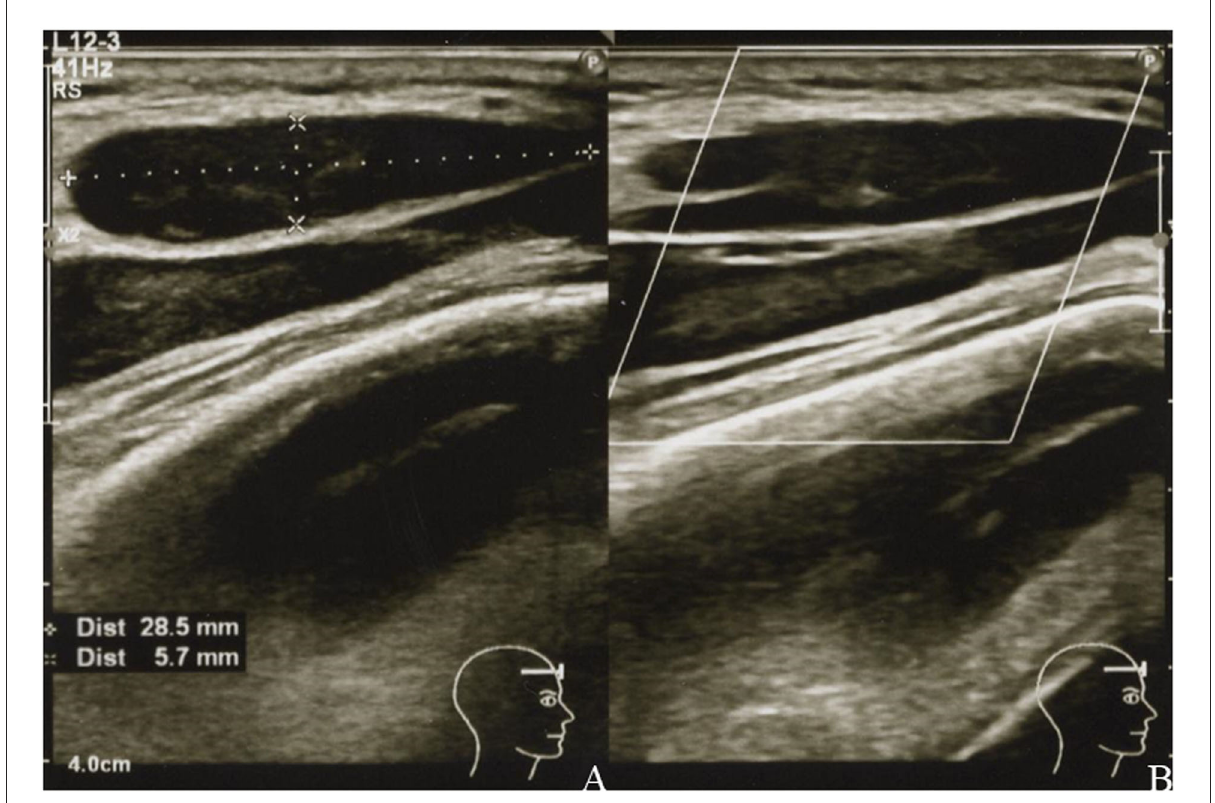
FIGURE2 Grayscale (A) and color Doppler (B) images of the right temporal mass showing a uniformly hypoechoic teardrop-shaped mass with well-defined margins (A) and decreased vascularity (B) .